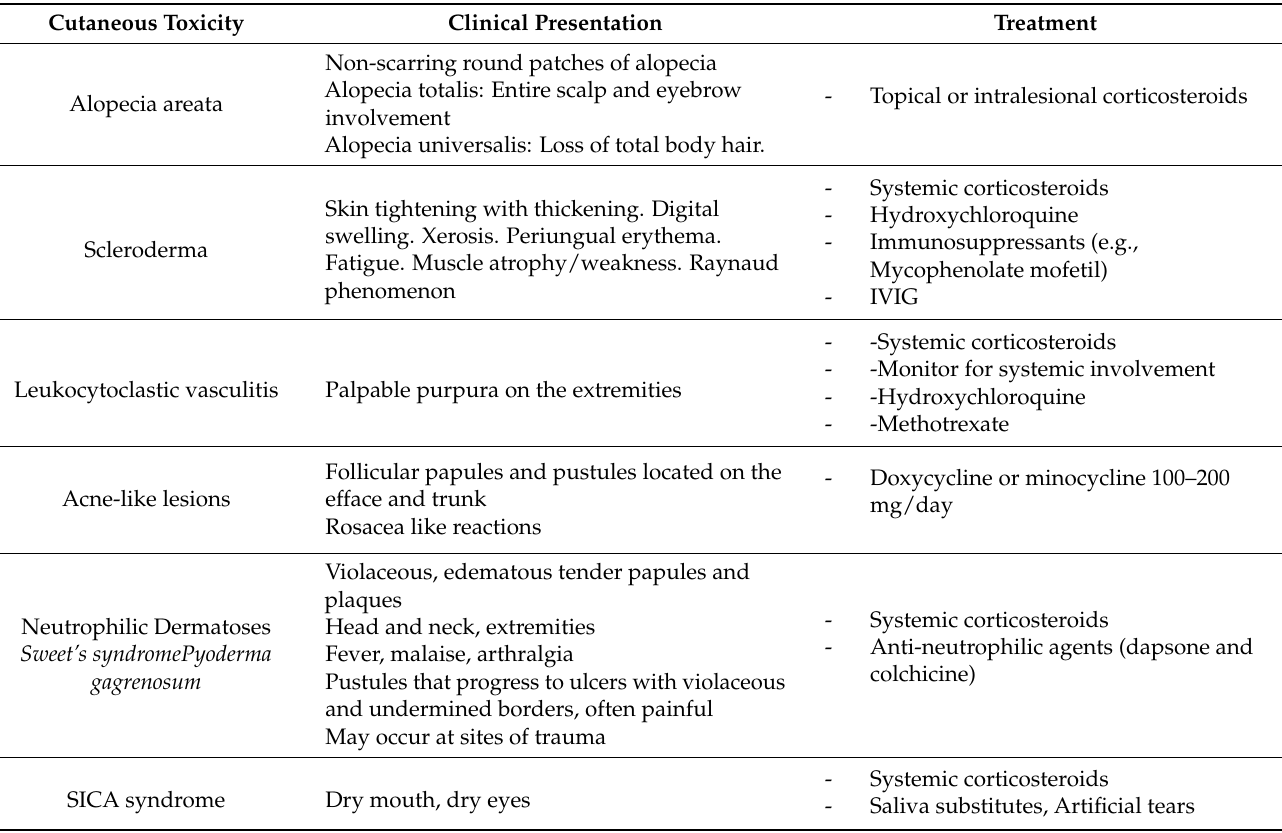
Table 2. Uncommon cutaneous